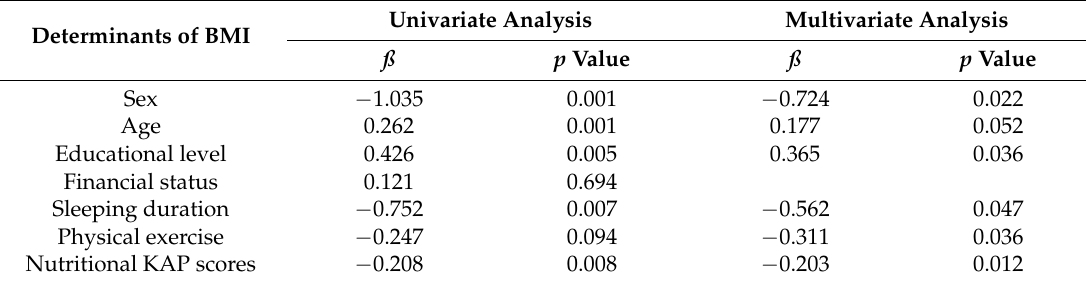
Table 3. Association of determinants with nutritional status.